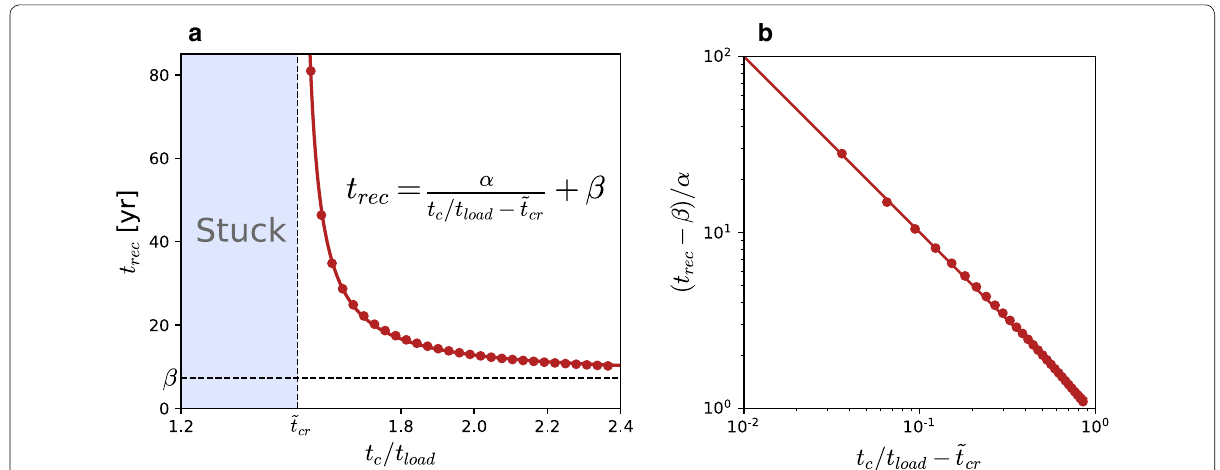
Fig. 5 Change in the recurrence interval due to viscoelastic relaxation. a Plot of the recurrence interval of earthquakes t rec as a function of t c / t load with R EL c / R = 0.35 . A solid line represents the best-fit model to the simulation results which diverges at law decay with a slope of −